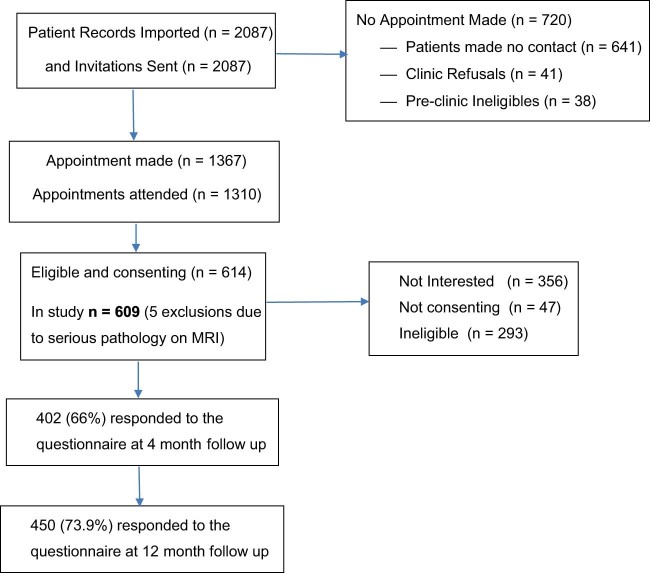
Flowchart of study population.